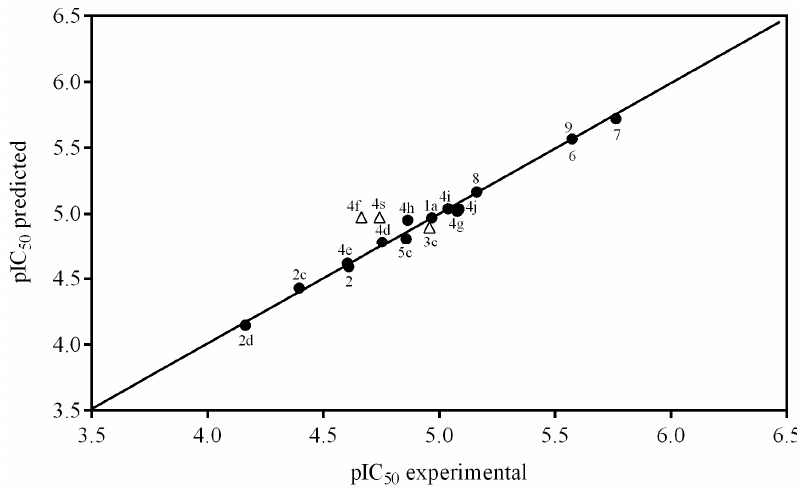
Figure 2. Correlation between predicted and experimental cytotoxic activity (pIC 50 ) of training (dark circles) and test (light triangles) sets using the best comparative molecular field analysis (CoMFA) model.